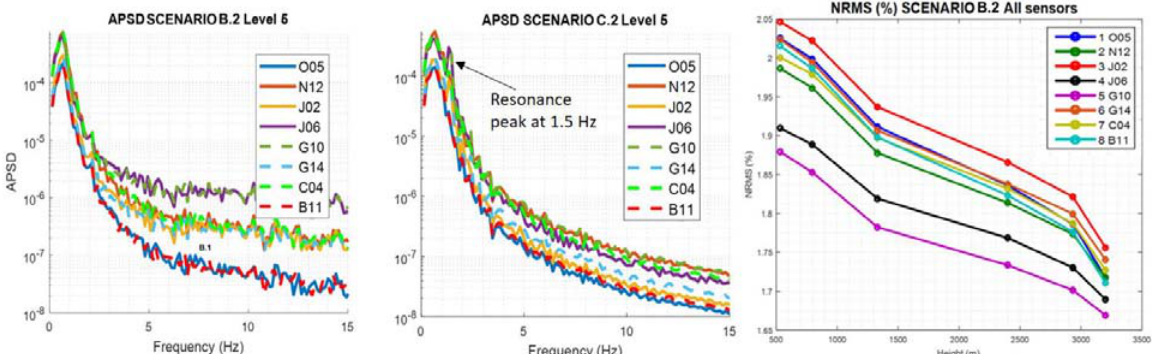
Figure 2: Scenario B.2 (left) and Scenario C.2 (center) APSDs of the radial positions at axial level 5. NRMS of the Scenario B.2 at all radial locations (right).